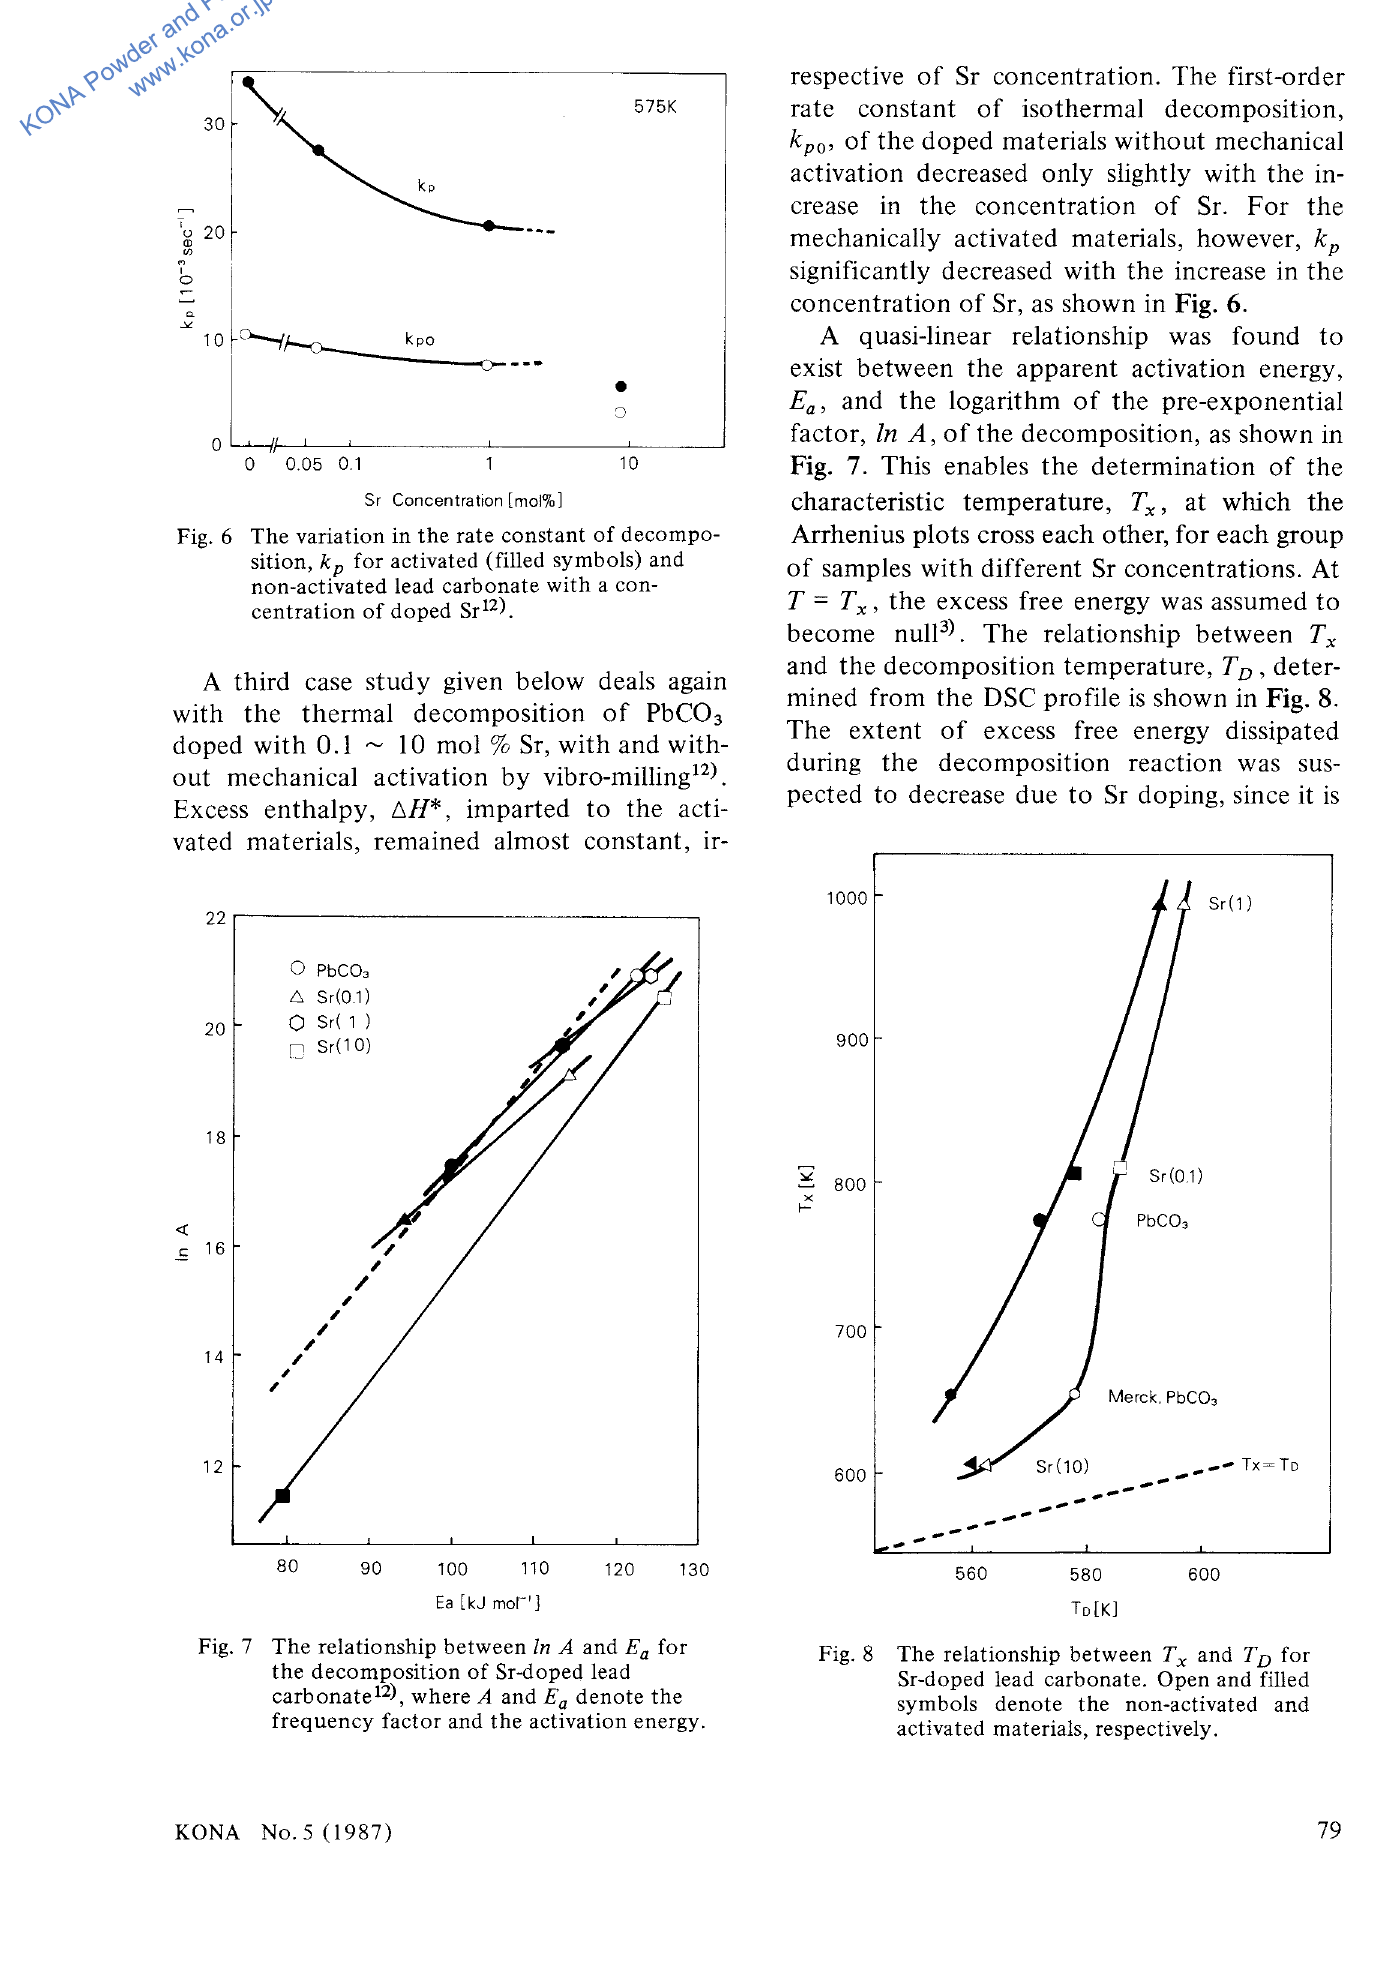
Fig. 7 The relationship between In A and Ea for the decomposition of Sr-doped lead carbonate 12), where A and Ea denote the frequency factor and the activation energy.